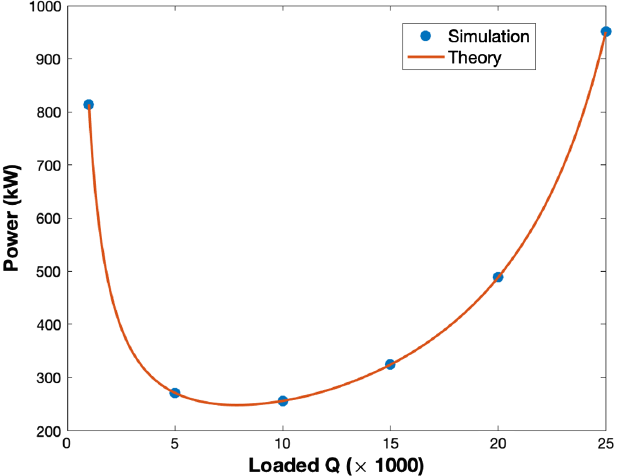
. FIG. 25. Average klystron power with detuning. L